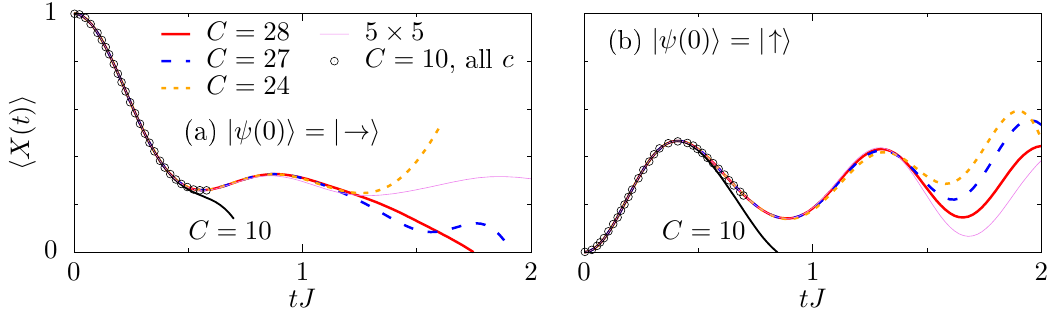
Figure 5: Dynamics of the transverse magnetization 〈 X ( t ) 〉 for a two-dimensional square lattice with transverse field g = 1, obtained by NLCE with rectangular clusters and expansion orders C = 24,27,28. The open circles are NLCE data digitized from Ref. [ 72 ] , where all (also nonrectangular) cluster geometries with up to 10 lattice sites have been considered. In addition, we present data from a rectangle expansion up to C = 10 which, in comparison, converges to slightly shorter times than the full expansion. The dynamics for a 5 × 5 lattice with PBC is shown as well. The initial state is chosen as (a) | ψ ( 0 ) 〉 = |→〉 and (b) | ψ ( 0 ) 〉 = |↑〉